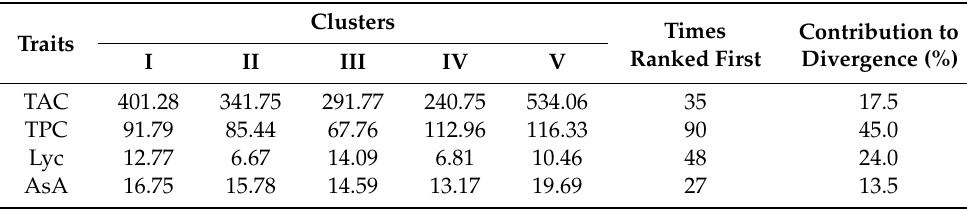
Table 4. Cluster‘s mean for five traits of tomato landraces and the contribution of each trait to the total divergence.